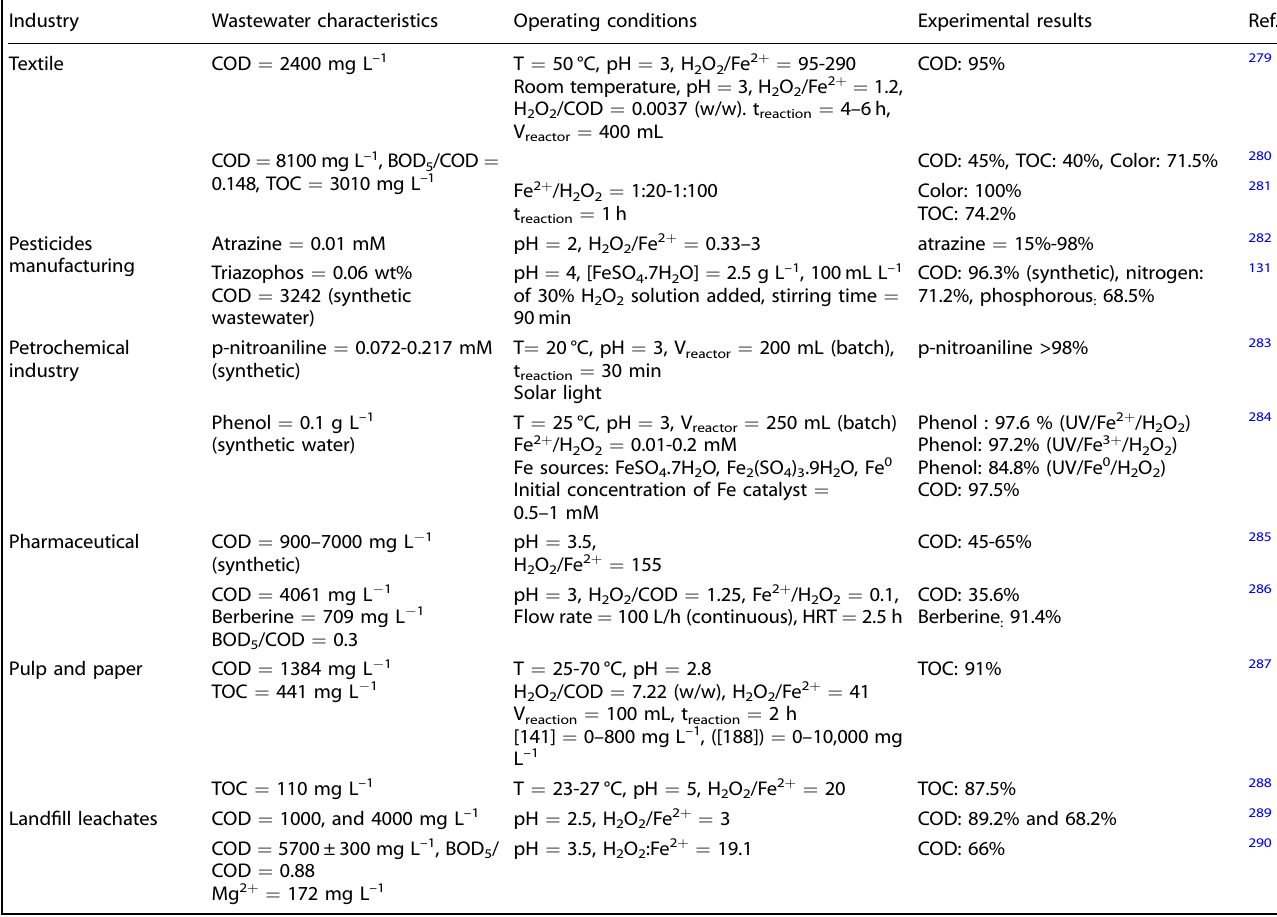
Table 4. Operational conditions and observed results of Fenton-based oxidation to various types of wastewaters. Industry Wastewater characteristics Operating conditions Experimental results